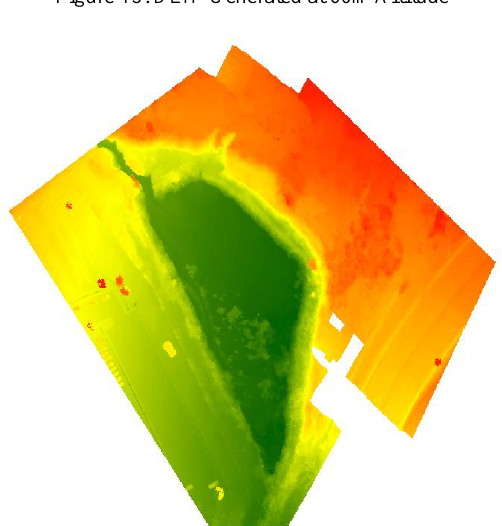
Figure 15. DEM Generated at 60m Altitude